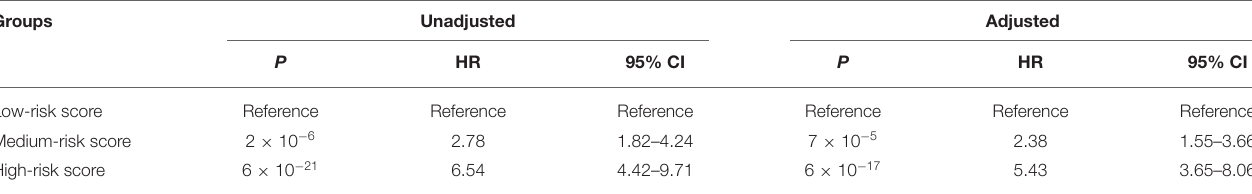
TABLE 5 | Prognosis analysis for groups with different risk score using Cox proportional hazards regression model. Groups Unadjusted Adjusted P HR 95% CI P HR 95% CI Low-risk score Reference Reference Reference Reference Reference Reference Medium-risk